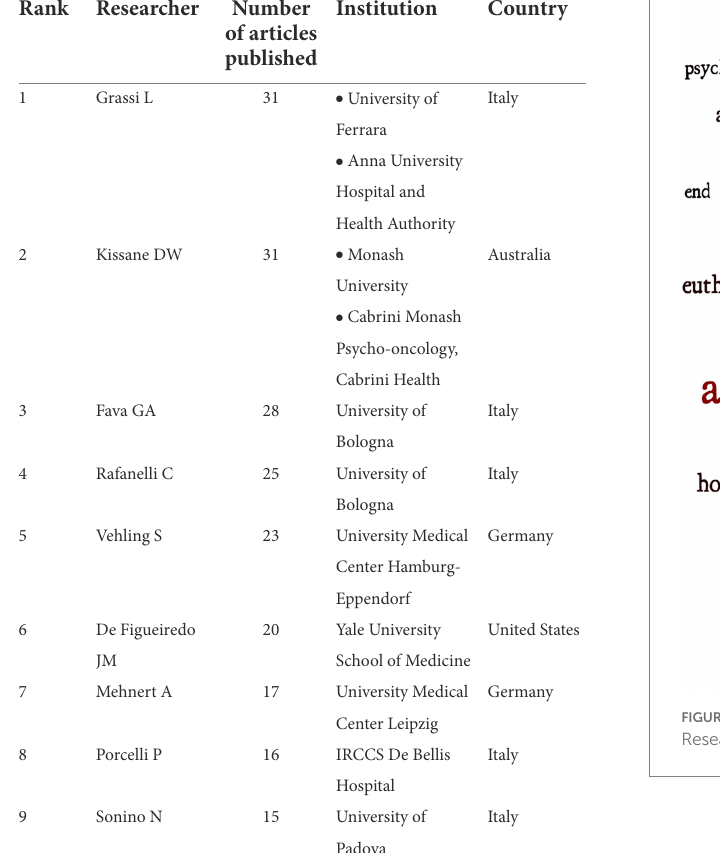
TABLE 3 Author and institution information of more than 15 publications.